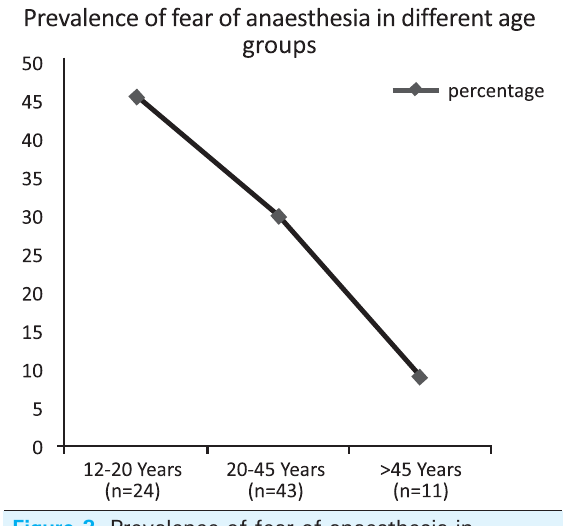
Figure 1. Prevalence of knowledge regarding modalities of anaesthesia (n=78)